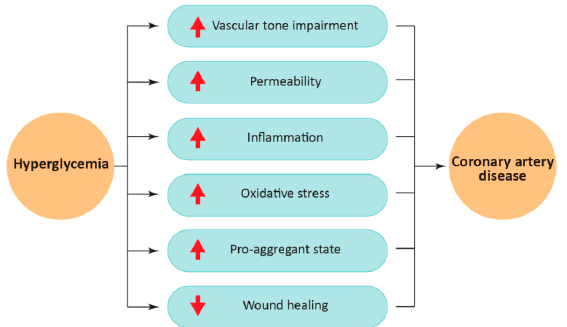
Figure 3. A schematic representation of how hyperglycemia-induced processes affect the pathogenesis of coronary artery disease. of coronary artery